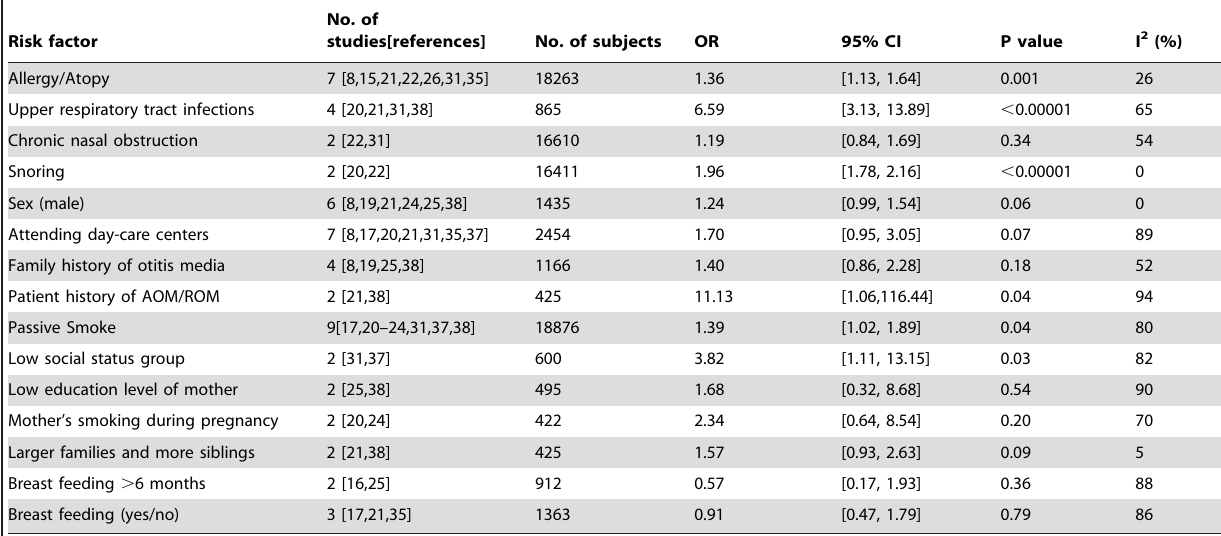
Table 2. Pooled analysis of risk